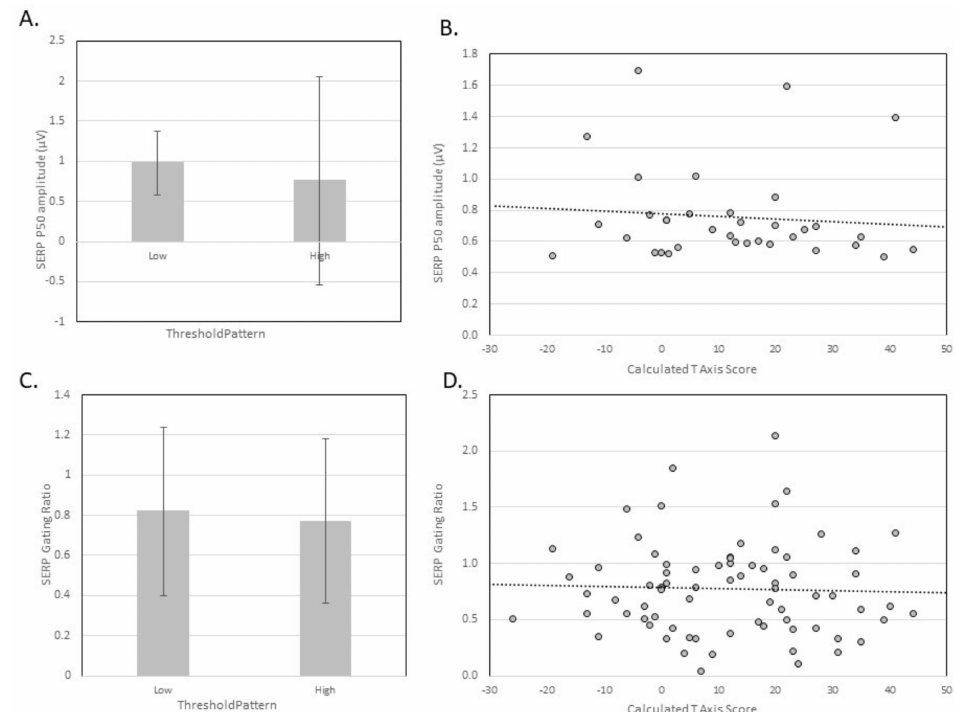
Figure 3. Relationship of somatosenory evoked potentials and gating to Dunn’s Threshold axis. ( A ) Mean and standard deviation of the SERP P50 amplitude for participants categorized as having low or high threshold patterns according to the quadrant with the highest raw score on the A/ASP. ( B ) Scatterplot of SERP P50 amplitude and calculated T axis scores. ( C ) Mean and standard deviation of the SERP gating ratio for participants categorized as having low or high threshold patterns according to the quadrant with the highest raw score on the A/ASP. ( D ) Scatterplot of SERP gating ratio and calculated T axis